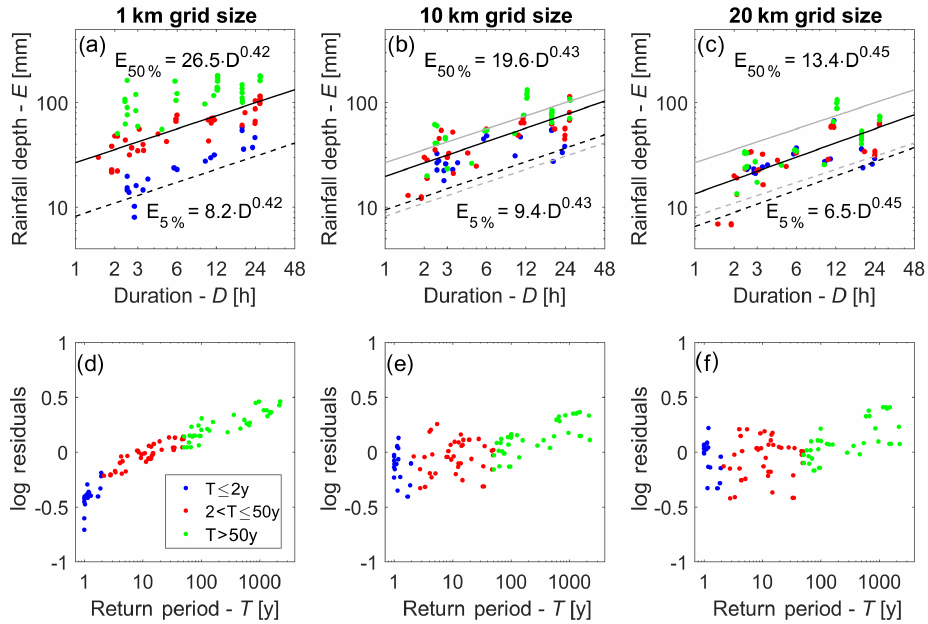
Figure 3. Threshold and regression relationships for 1, 10, and 20km grid sizes ( a–c , respectively) and corresponding residuals of the regressions in logarithmic scale (log residuals) as a function of the return period of the 1km triggering rainfall (d–f) . Light grey lines in (b) and (c) reproduce, for reference, the 1km grid size relationships.